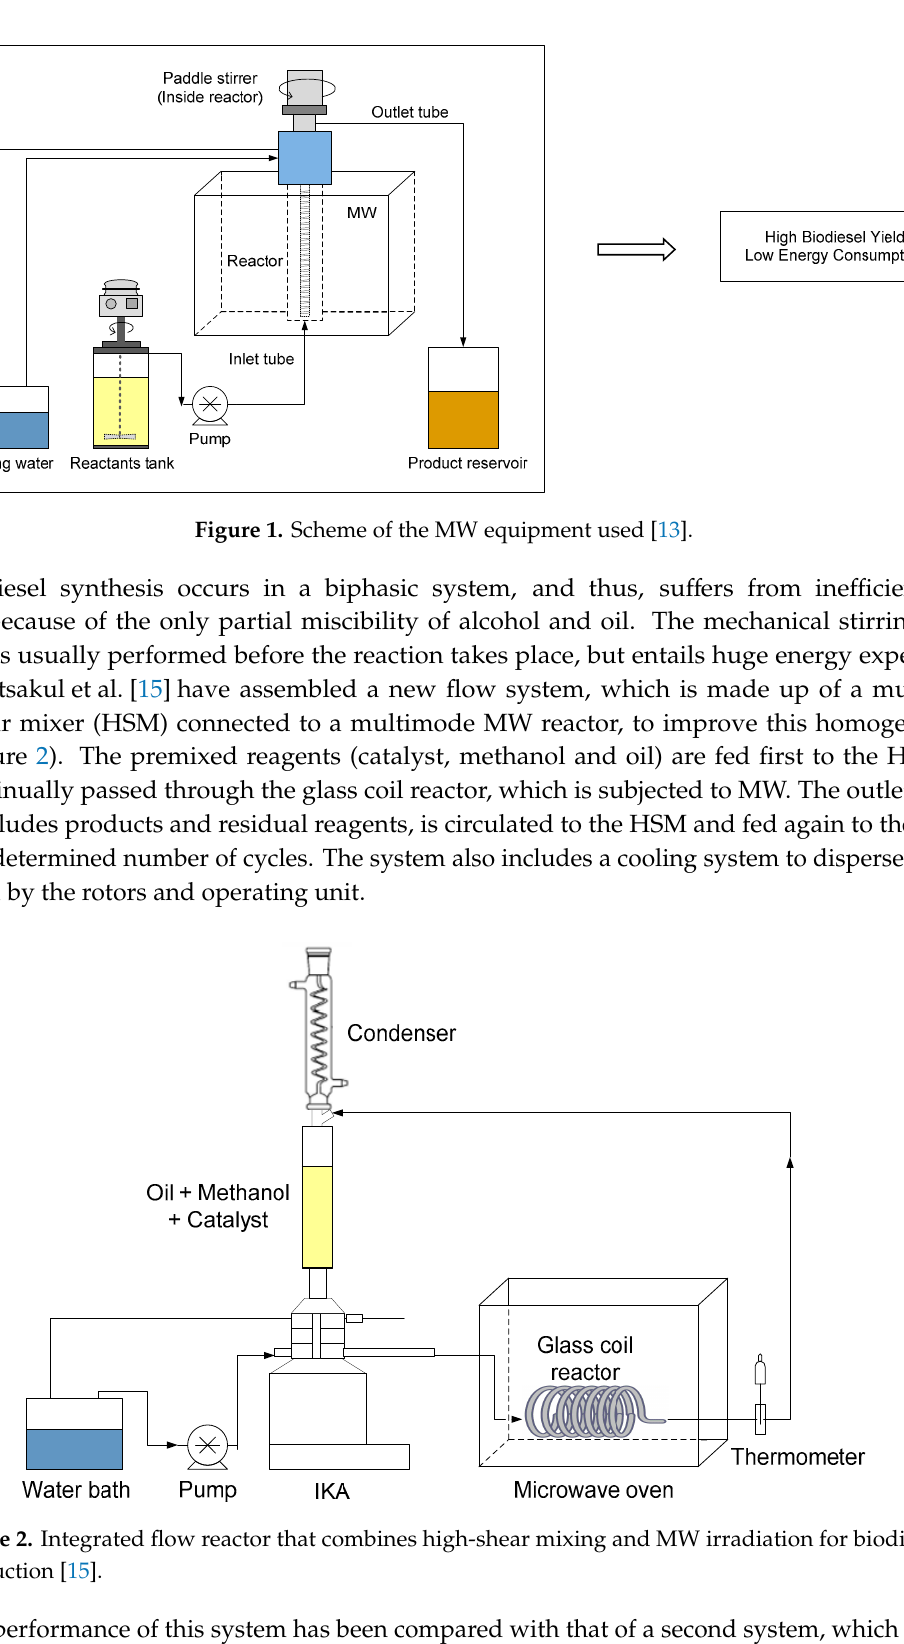
Figure 3. Scheme of mono-mode MW reactor for biodiesel synthesis [16]. In this study, a Miniflow, a mono-mode device, was used. The reactants enter the reactor, where they are mixed, and the reaction products exit through the outlet at the top. The heat input is automatically and continuously adjusted to keep the temperature at 40 °C, whereas the residence time is changed with the flow rate. The results show that the enhancing effect of MW is particularly strong when the catalyst concentration is about 0.25%, but a stationary time of 180 s is needed.